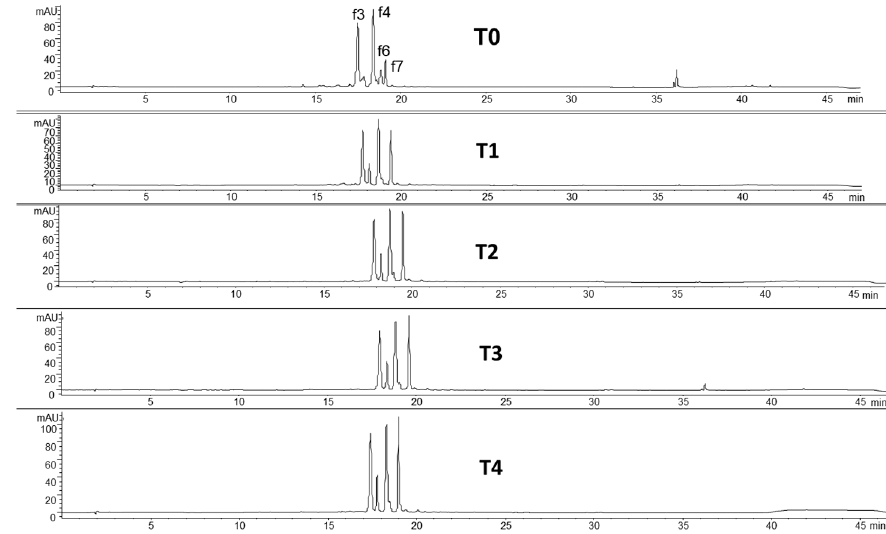
Figure 2. Chromatographic profiles at 350 nm of the fermented millet (FM1): at time 0 (T0), after 24 (T1), 48 (T2), 72 (T3) and 96 (T4) hours of fermentation. f3, luteolin (7- O -glucopyranosyl) 8- C -glucopyranoside; f4, vicenin II; f6, vitexin 2”- O -rhamnoside; f7,